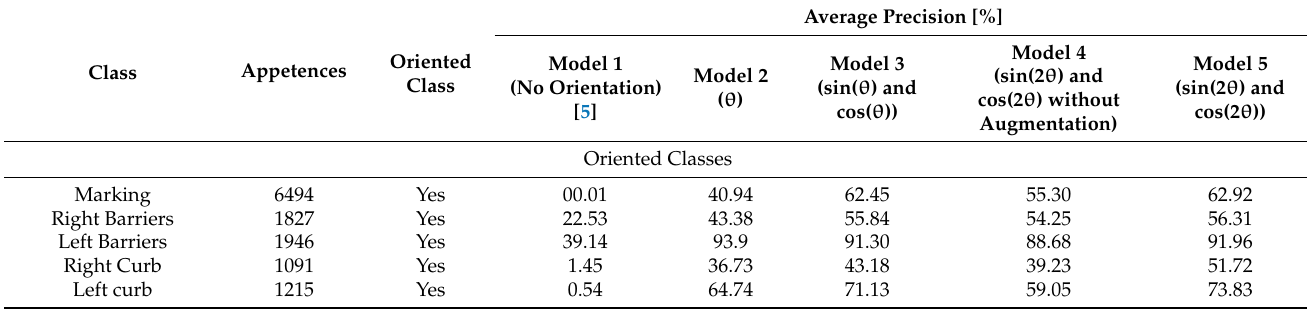
Table 4. Average precision per class for different